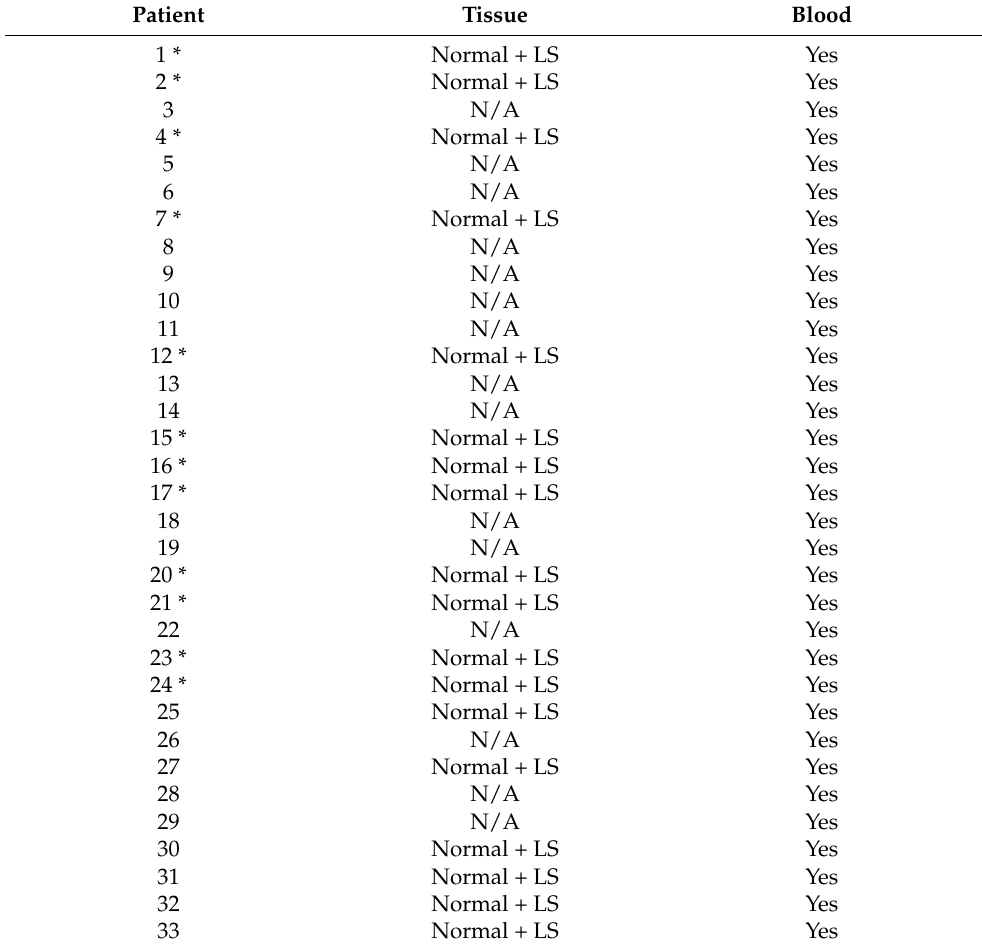
Table 1. Clinical samples of tissue and blood from patients with active lichen